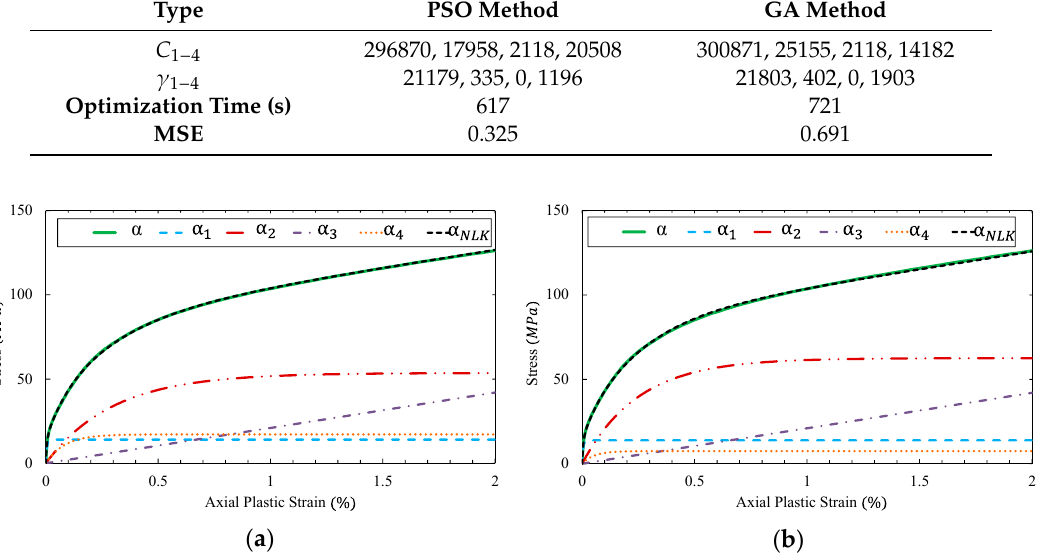
Figure 16. Comparison of α and α NLK curves using four Chaboche components for post-stabilized